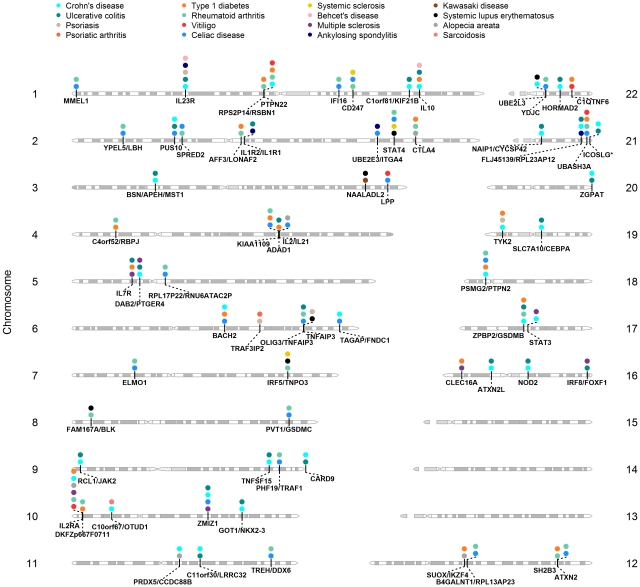
Shared loci between GWAS of ADs.Gene regions are below each chromosome, diseases where it was reported are above, represented by a colored circle.